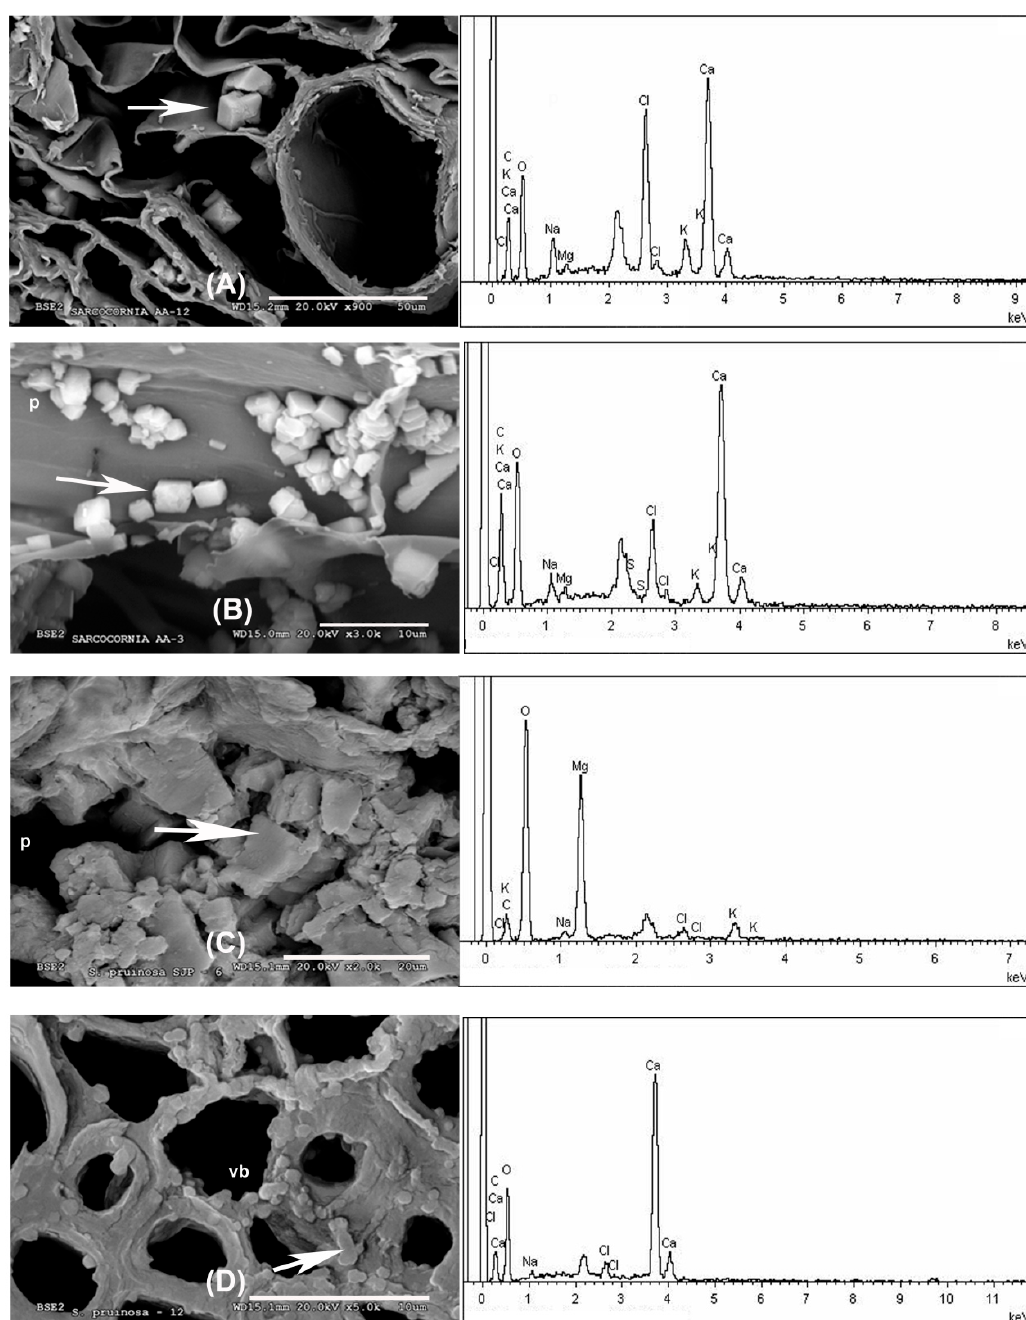
Figure 4. SEM images representative of Ca and Mg biominerals in succulent stems of S. pruinosa . ( A ) Cubic structures of Ca in parenchyma. ( B ) Ca crystals in the parenchyma cell walls in longitudinal section. ( C ) Detail of Mg in the parenchyma. ( D ) Detail of the Ca crystals. EDX spectra to the right of each section corresponds to the analyzed spot represented by the white arrow. Symbology: p = parenchyma; vb = vascular bundle.